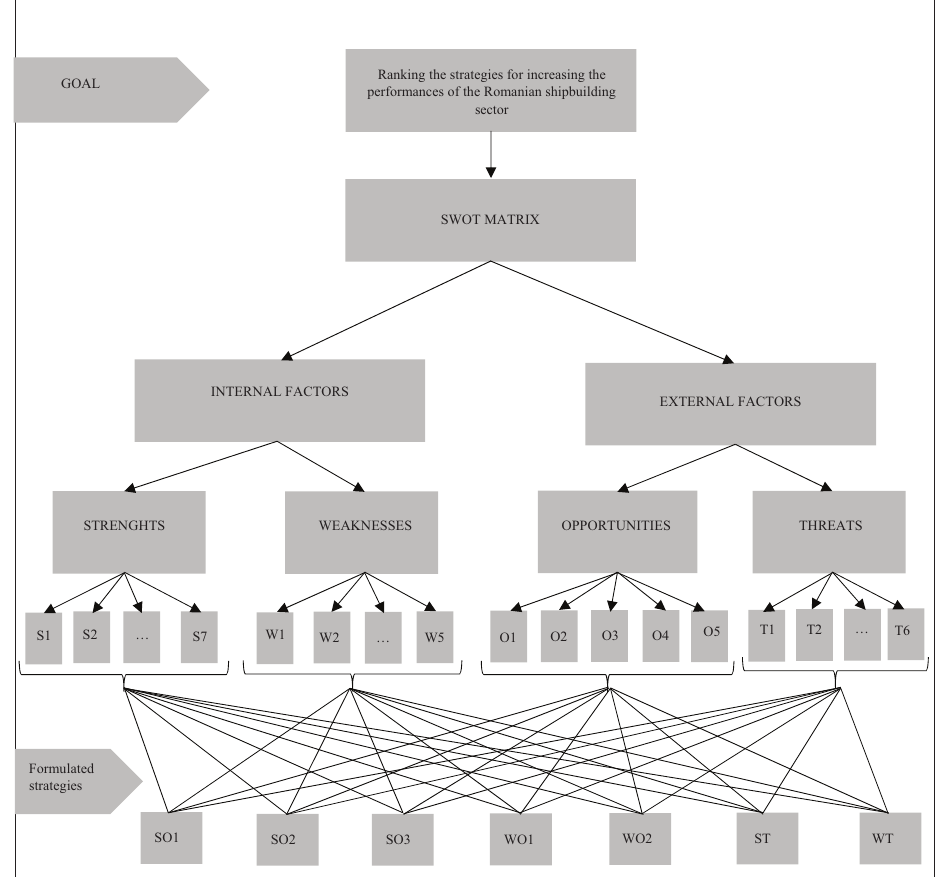
Figure 2. Hierarchical structure regarding the evaluation of the strategies aimed at increasing the performance of the Romanian naval